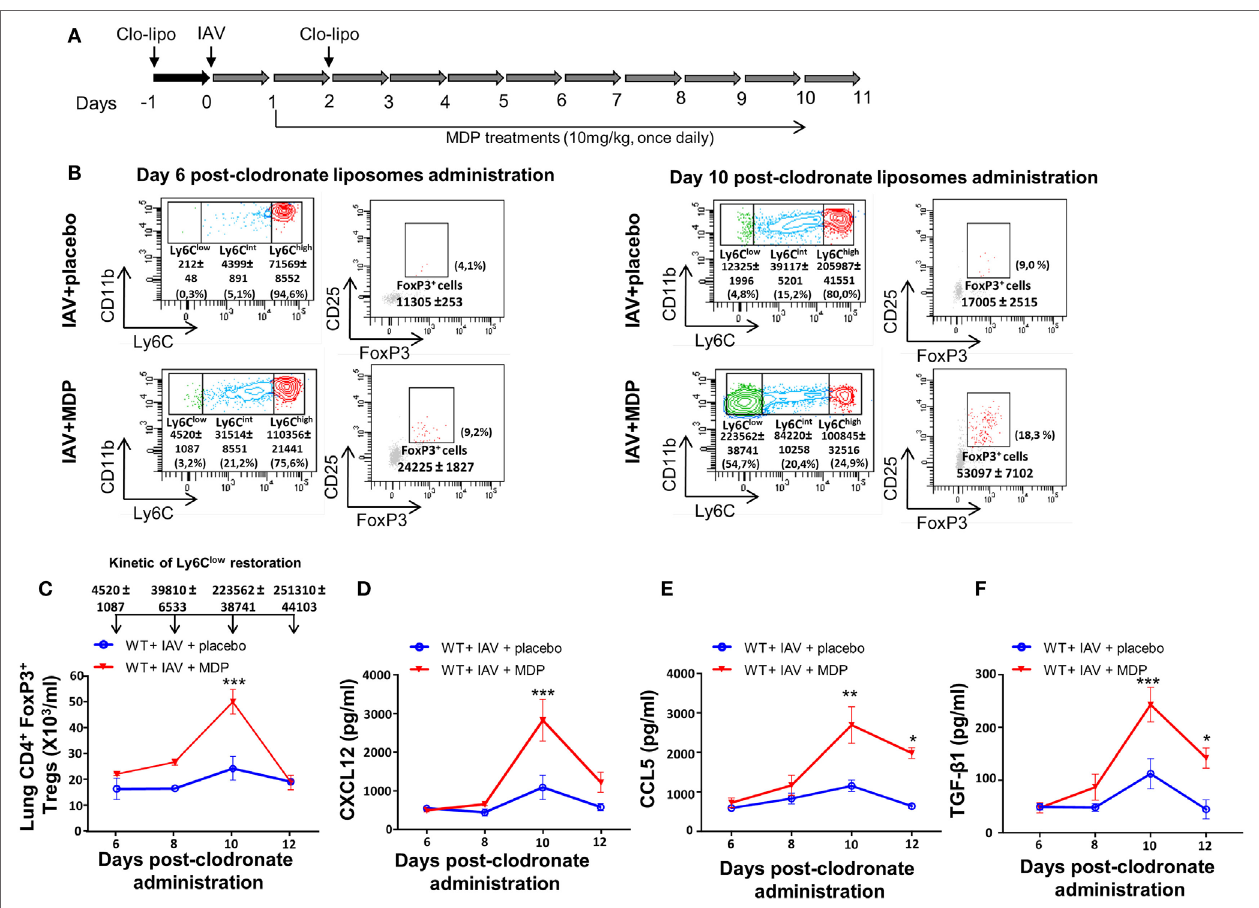
FigUre 6 | Sustained depletion of Ly6C low monocytes delays muramyl dipeptide (MDP)-induced regulatory T (Treg) recruitment in lungs of influenza A virus (IAV)-infected mice. (a) Experimental design of blood monocyte depletion. (B) Monocytes subsets quantification was measured at days 6 (left panels) and 10 (left panels) postclodronate liposome administration in IAV-infected mice daily treated with placebo or MDP. Flow cytometry analysis show monocyte subset replenishment at indicated times. In parallel, Treg cells renewal is also monitored at days 6 (right panels) and 10 (right panels) postclodronate liposome administration in IAV-infected mice daily treated with placebo or MDP. Numbers in parentheses express the percentage (%) of Treg cells on CD4 + T population. (c) Absolute numbers of lungs Tregs cells were measured at indicated time following clodronate liposome administration. Arrows show the number of blood Ly6C low monocytes detected in wild-type IAV-infected mice treated with MDP at days 6, 8, 10, and 12 postclodronate liposome administration. This kinetic of Ly6C low monocytes restoration applies to figure (c–F) . Levels of (D) CXCL12, (e) CCL5, and (F) TGF- β 1 in lung homogenates were measured at days 6, 8, 10, and 12 postclodronate administration in mice infected with IAV and daily treated with placebo or MDP. Results are presented as mean ± SEM of two independent experiments ( n = 4 mice/ groups). Differences in groups were determined with a two-way analysis of variance followed by a Sidak post hoc test. * p < 0.05, ** p < 0.01, and *** p < 0.001, when compared with IAV-infected animals treated with